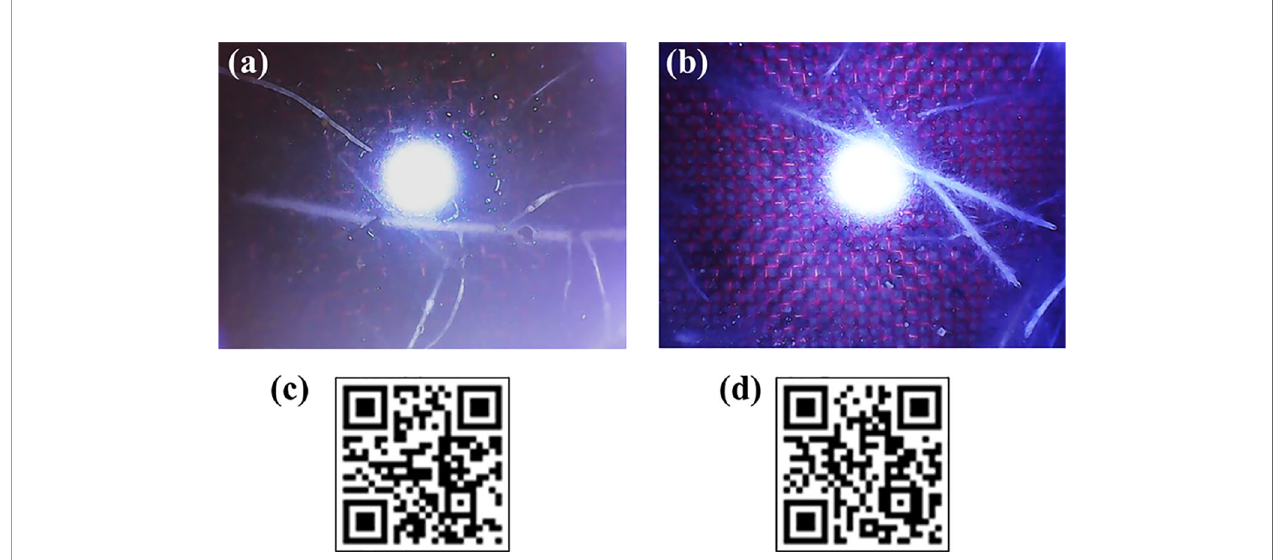
FIGURE 4 | Root images of maize (A) and grass (B) , and QR codes for root videos of maize (C) and grass (D) . The openings in red nylon wire mesh shown in a and b are 0.743